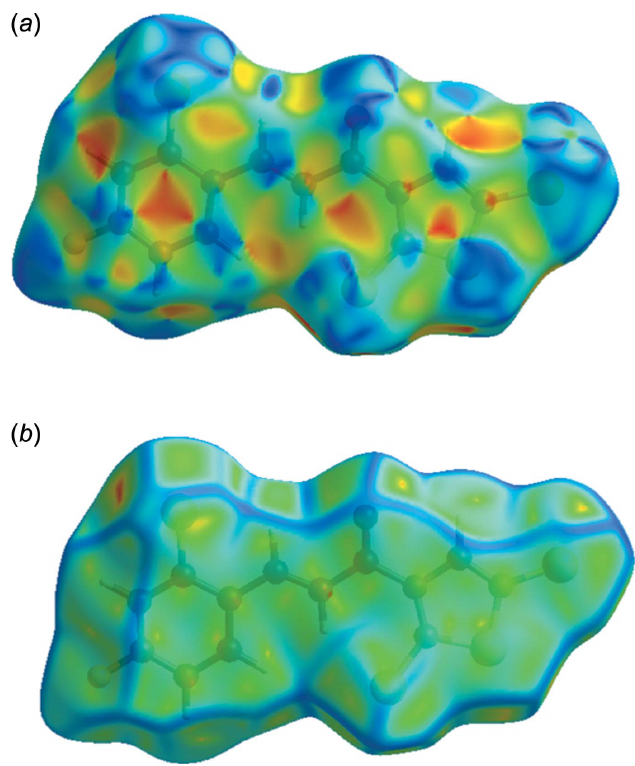
Figure 4 Hirshfeld surface of the title compound mapped over ( a ) shape-index and ( b )